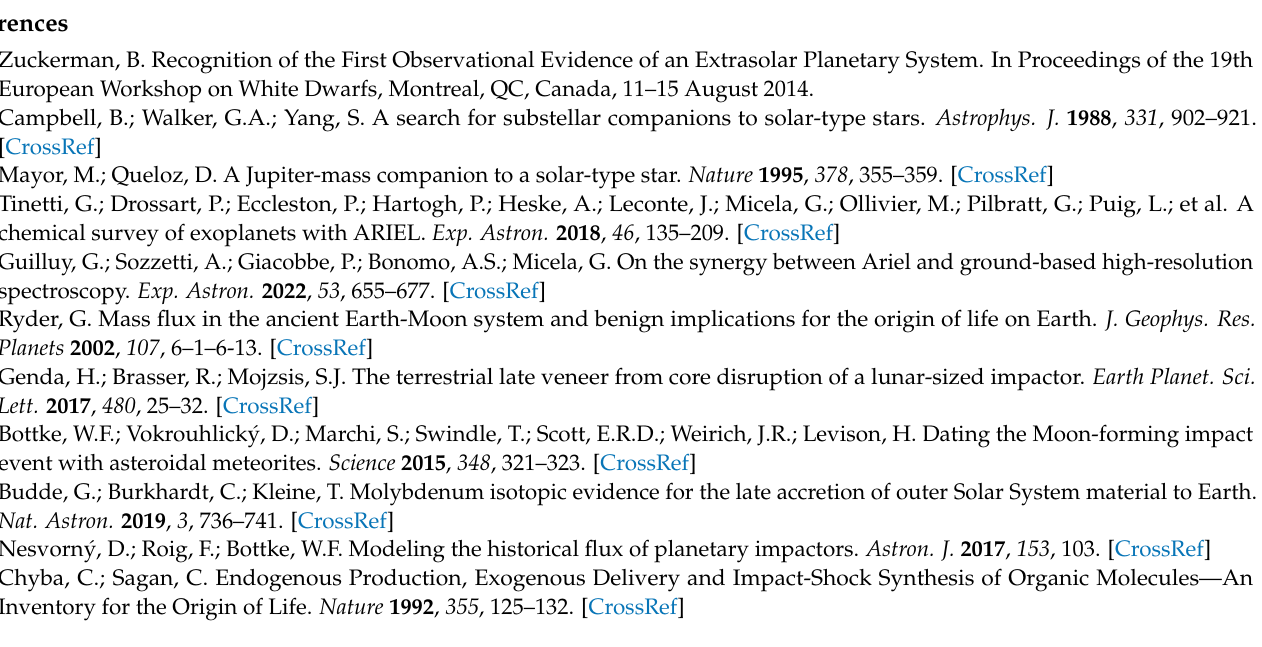
Table S8: Observed emission lines of the CH radical in the X 2 Π ground